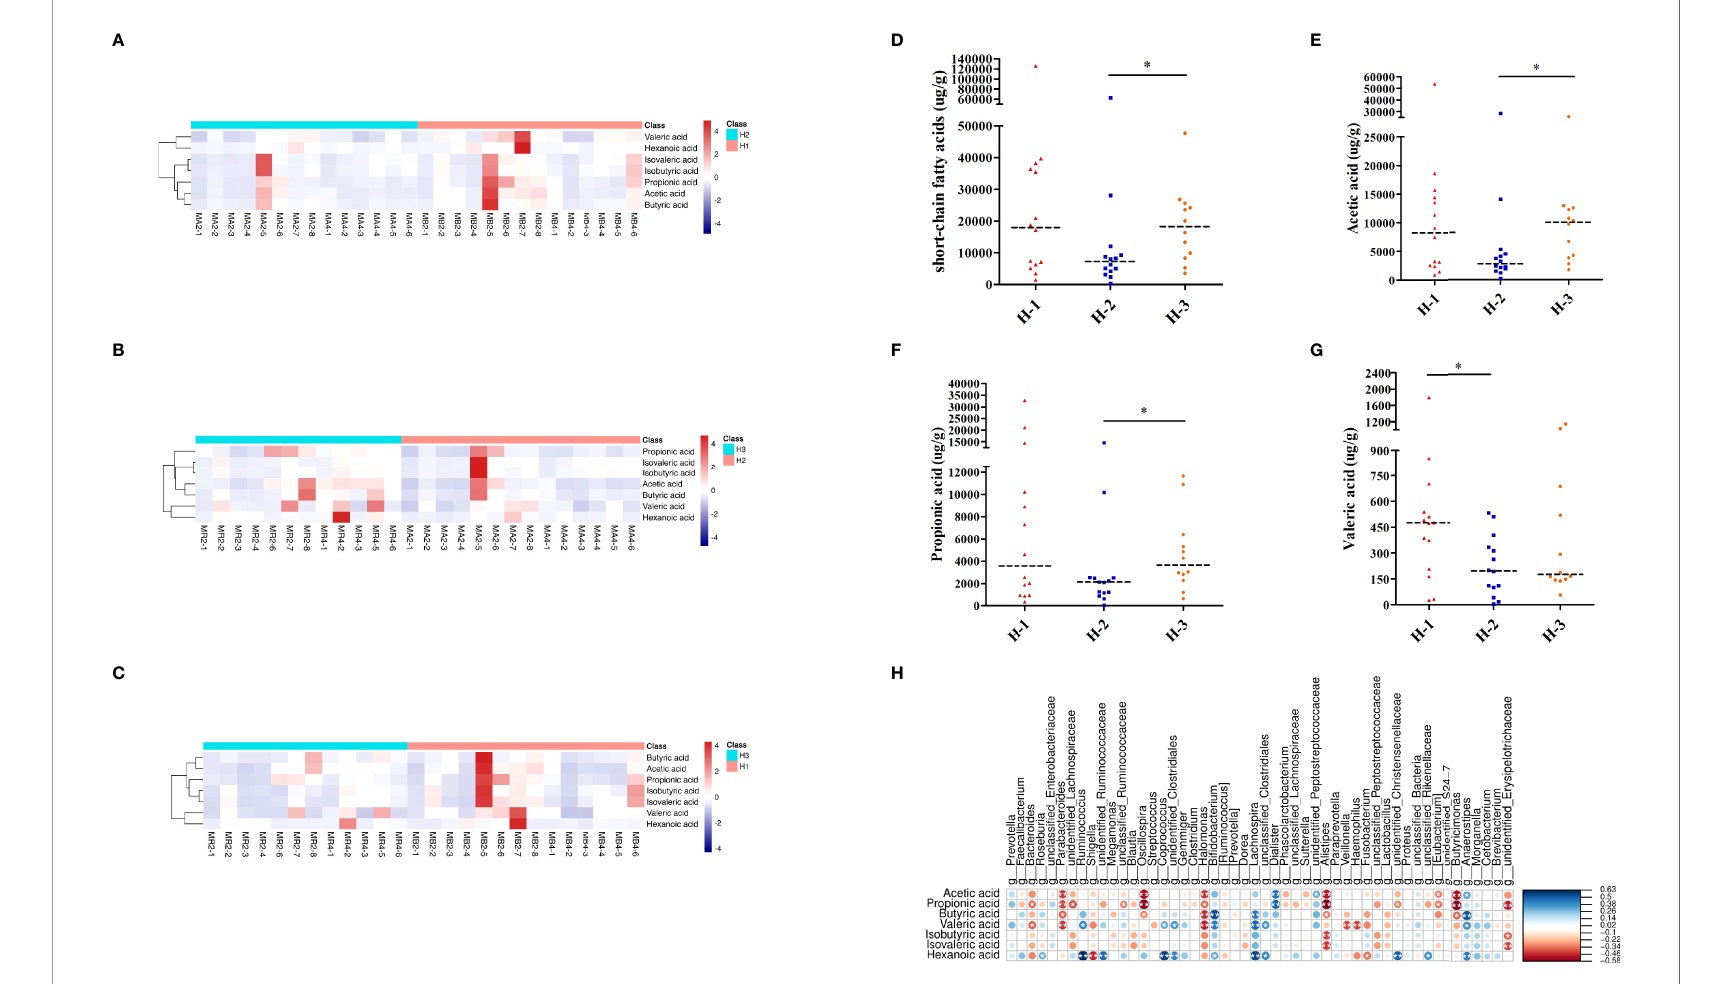
FIGURE 7 | SCFA analysis of H-VA therapy. Heatmap of SCFA differences across different samples at the three time points of H-VA therapy ( A for H-1 and H-2, B for H-2 and H-3, C for H-1 and H-3), red represents a positive association, and blue represents a negative association. The quanti fi cation of total SCFAs (D) , acetic acid (E) , propionic acid (F) , and valeric acid (G) at the three time points of H-VA therapy. (H) Integrated analysis of SCFA alterations associated with gut microbiota among the H-VA group, blue represents a positive association, and red represents a negative association. H-1: the time point before eradication in the H-VA group; H-2: the time point after eradication in the H-VA group; H-3: the time point of con fi rmation in the H-VA group; * P